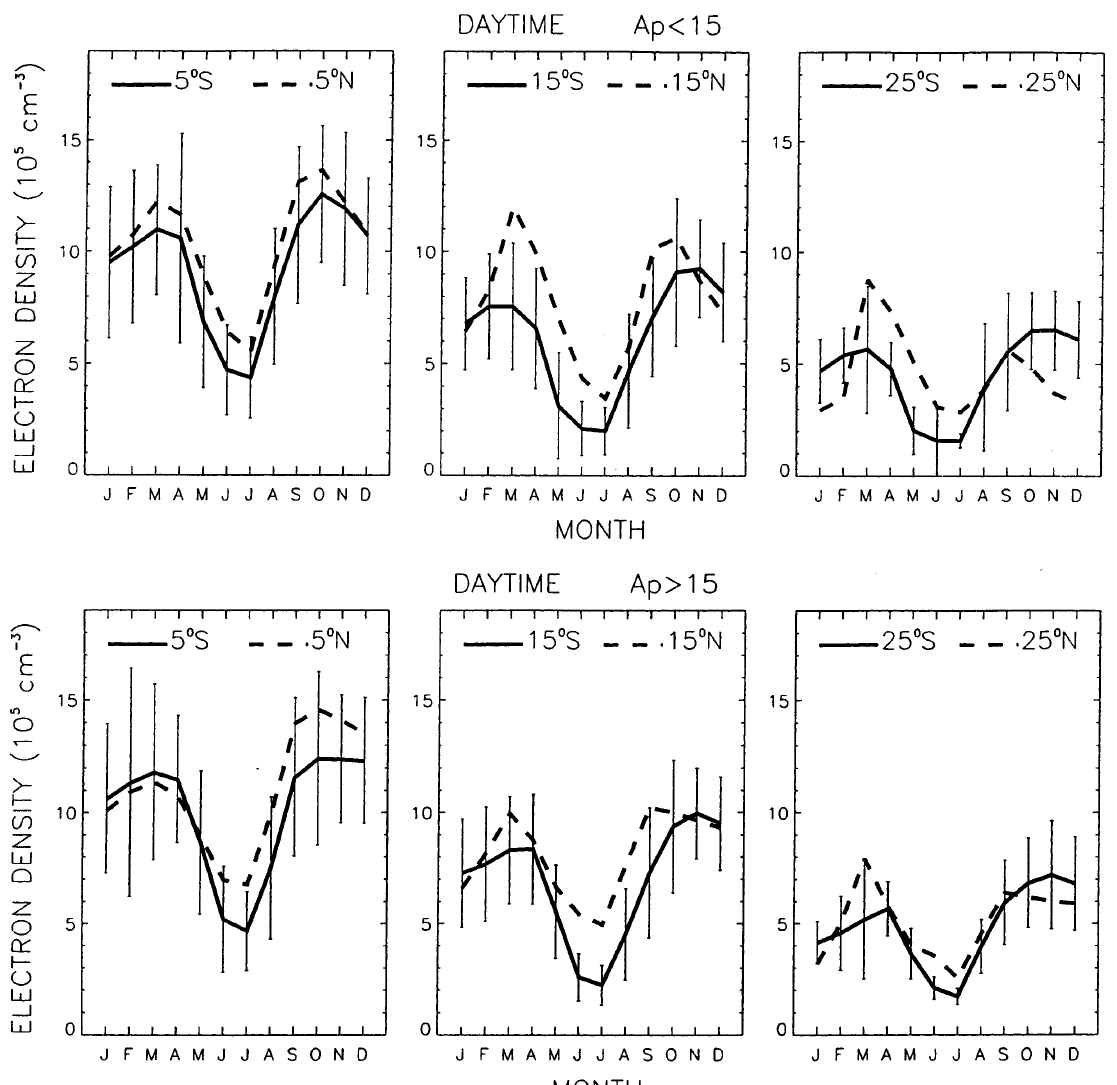
Fig. 4. Yearly variations of the daytime (09:00–17:00 LT) averaged electron density at magnetic latitudes 5 (cid:176) , 15 (cid:176) and 25 (cid:176) Southern Hemisphere ( solid curves ) and Northern Hemisphere ( dashed curves ) for low ( top panels ) and high ( bottom panels ) magnetic